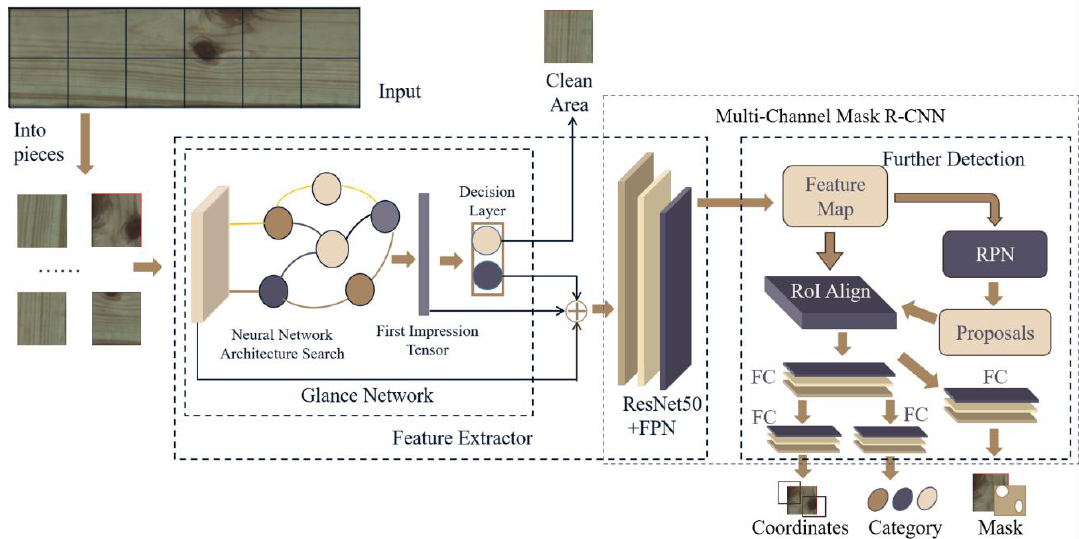
Figure 5. Structure chart of the target detection algorithm for wood defects detection. FPN: feature pyramid network; FC: fully connected network; RPN: region proposal network.